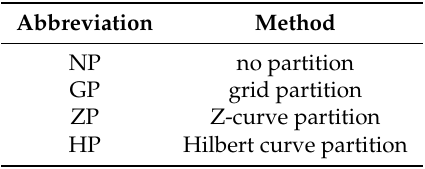
Table 4. Method comparison in experiment